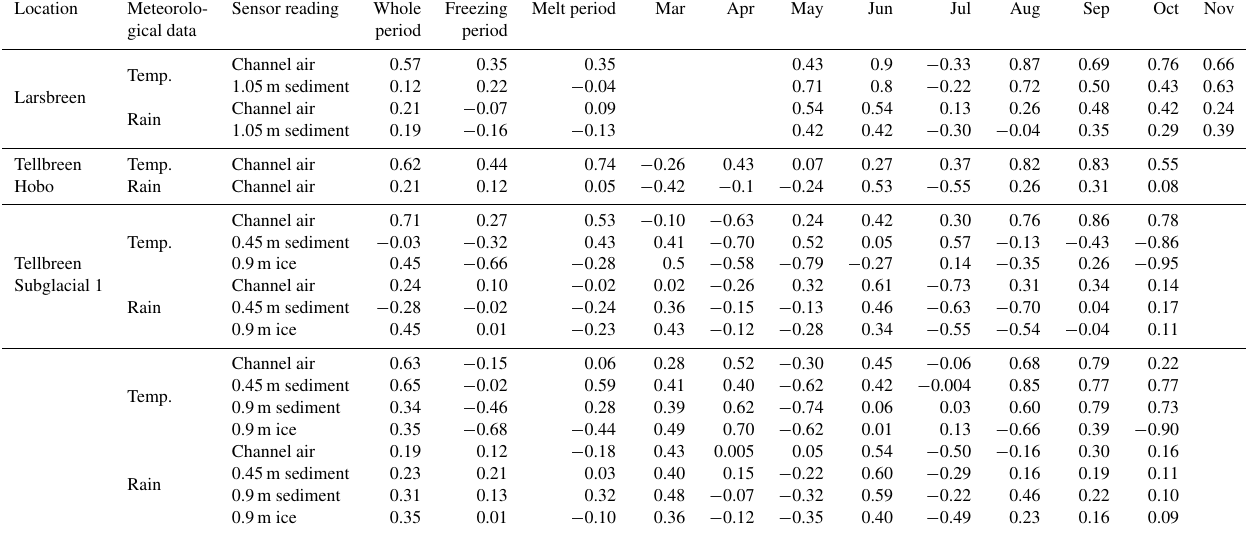
Table 1. Pearson correlation coefficients for all sensor records with surface air temperature and rainfall for the whole time period and sub- periods. Correlation coefficients can be classified following Evans (1996): very weak (0.00–0.19), weak (0.20–0.39), moderate (0.40–0.59), strong (0.60–0.79) and very strong